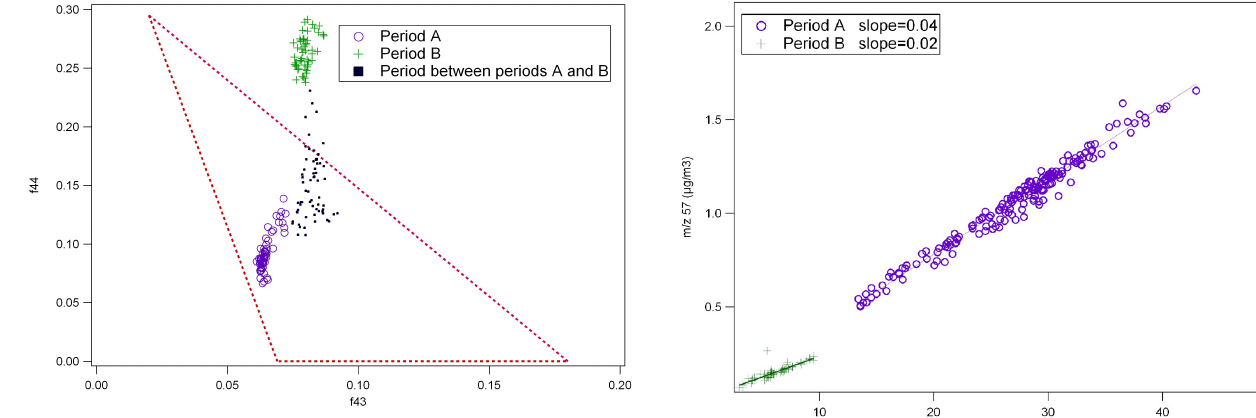
Fig. 8. m/z 57 mass versus the total organic mass for the two peri- ods: Period A (marked by purple circles) represents freshly emitted aerosols. Period B (marked by green crosses) represents aged oxi- dized aerosols.